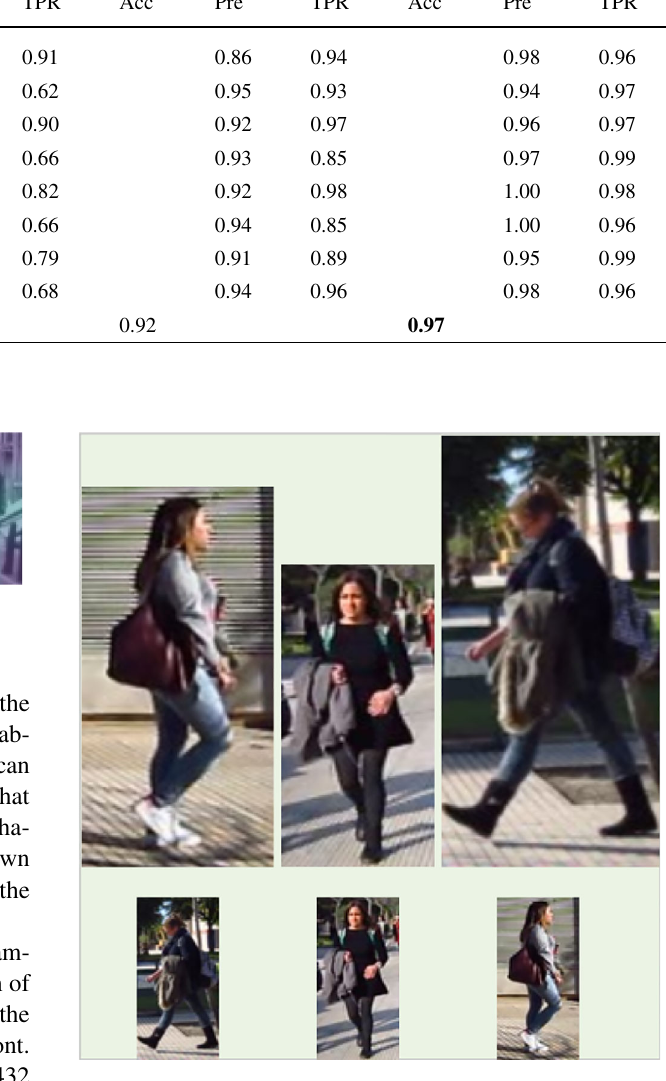
images, as shown in Fig. 15. After that, the black back- ground frame images are used as input for various CNN variant models (such as AlexNet, GoogLeNet and ResNet- 50). Compared with our algorithm, this method requires data preprocessing and cannot achieve end-to-end learning, which increases the processing time of the model and greatly reduces the efficiency. Table 5 shows the acc , pre and TPR of all methods. Our method achieves an acc of 91%, the highest among all methods. The recognition results of all algorithms are shown in the confusion matrices in Fig.